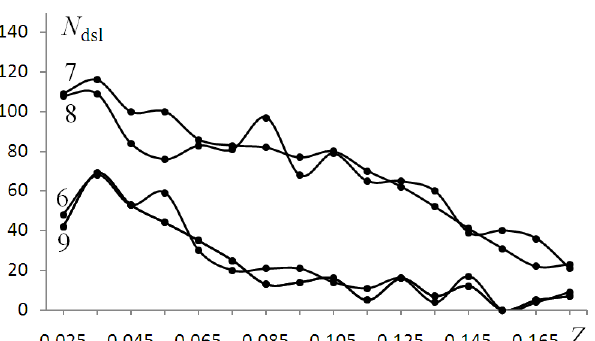
Figure 11. Dependence of dislocation number on distance Z passed by the beam. Calculation was performed for a beam with phase specified by two comas (polynomial numbers and number of curves are 7 and 8) and by trefoils (polynomials and curves are 6 and 9). The radius of registration region is 1.4 of the initial radius of the beam.